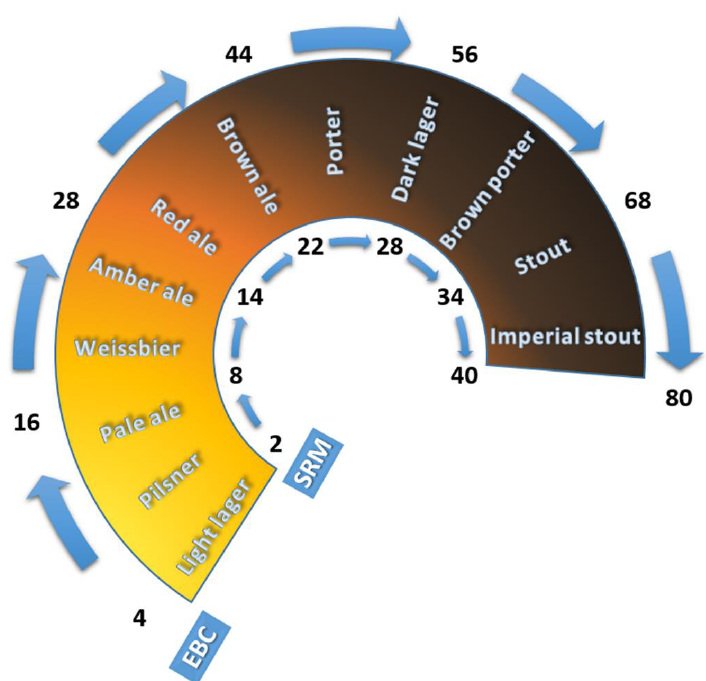
Figure 11. European Brewery Convention (EBC) and Standard Reference Method (SRM) color values of various beer types. Photometry can be used for color determination of beer and malt [9], and color can be expressed with a tristimulus CIELab color model, were L is the lightness component, a refers to the degree of the red and green, and b to the degree of the blue and yellow color. Lightness ( L value) is strongly correlated with the conventional EBC scores [41]. To replace the conventional visual color assessment